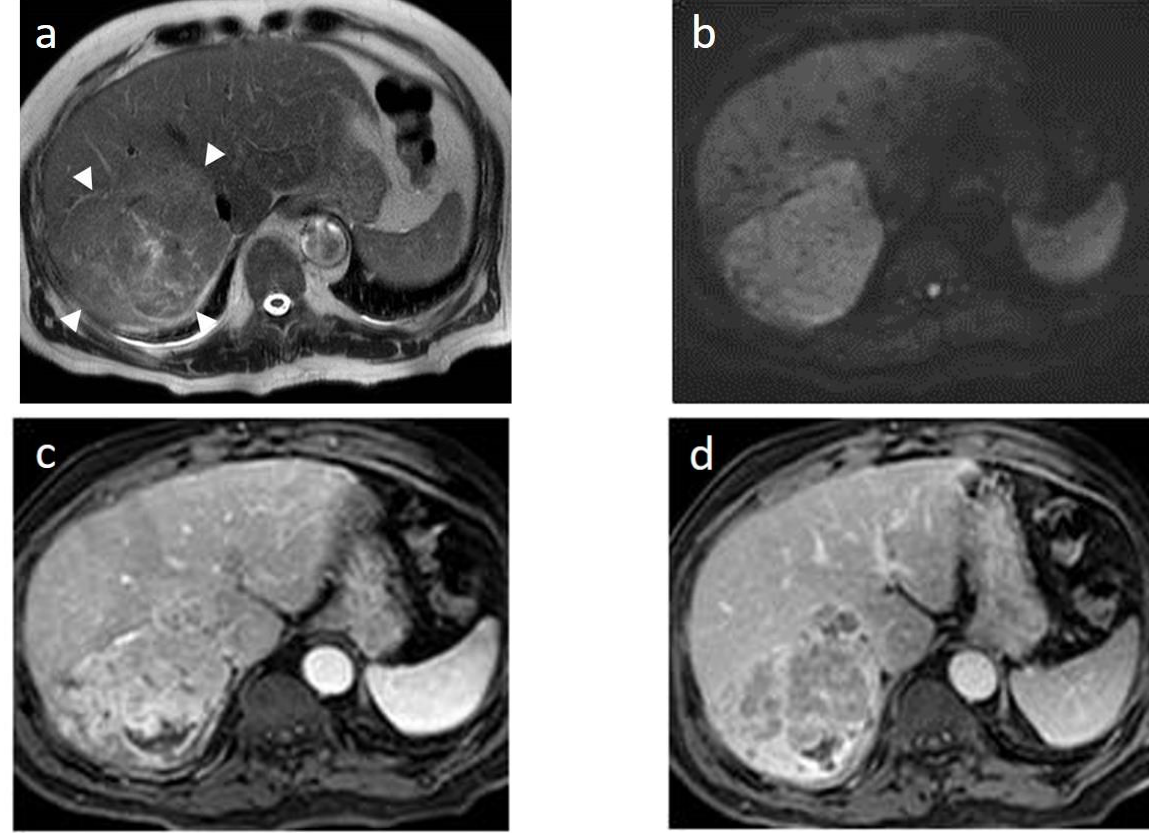
Figure 14. An 11-cm tumor (arrowheads) is incidentally discovered in a 70-year-old man without history of viral hepatitis, non-alcoholic fatty liver disease, or cirrhosis. Otherwise, the lesion shows typical HCC imaging features such as high T2 signal intensity ( a ), diffusion restriction ( b ), arterial hyperenhancement ©, and wash-out during the portal phase ( d ). Due to the absence of risk factors, a biopsy was performed that confirmed the radiological